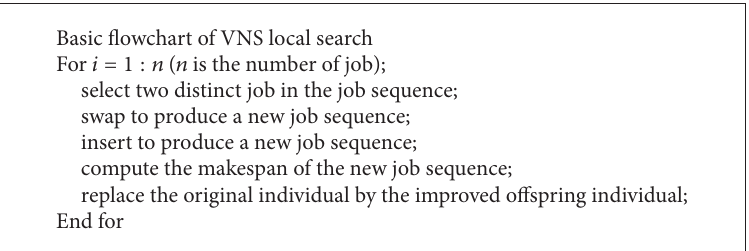
Algorithm 4: The basic flowchart of IIS local